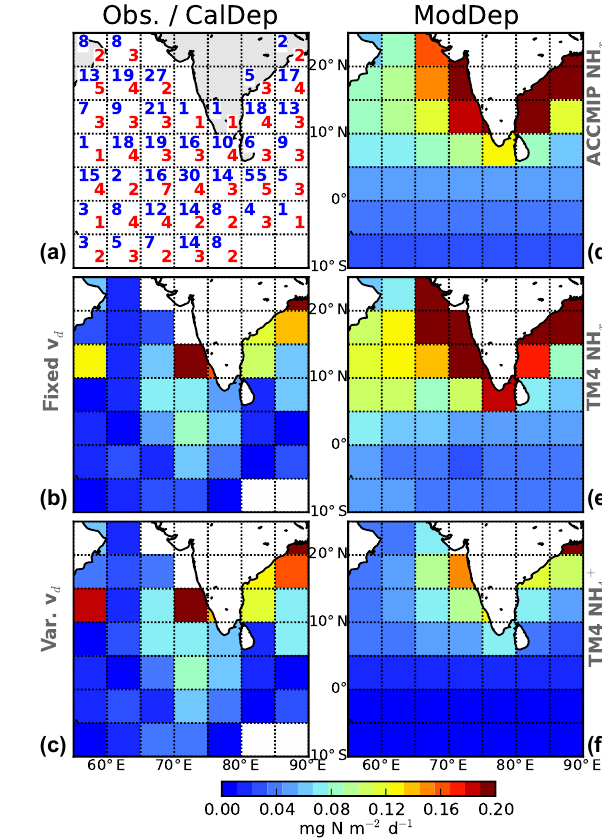
Figure 11. Dry deposition fluxes (mg Nm − 2 d − 1 ) for NH + /NO y 3 for the NInd region. Panels are as described in Fig.